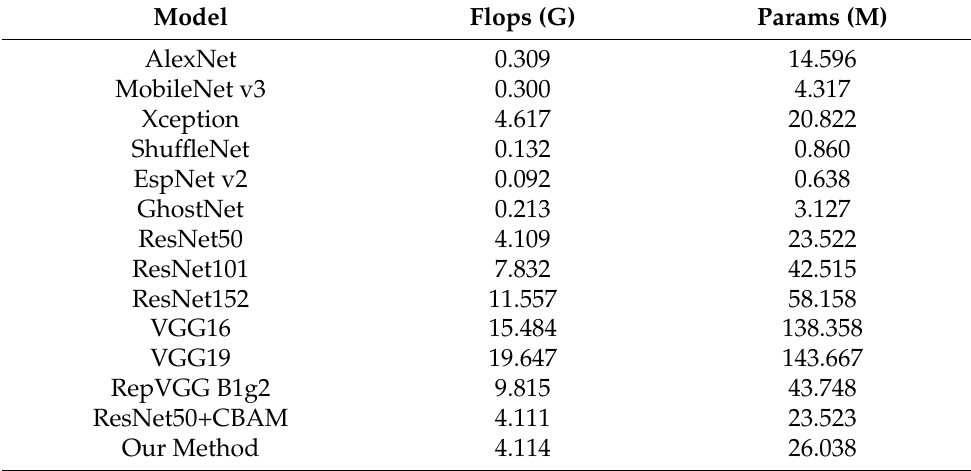
Table 3. The comparision of model complexity.